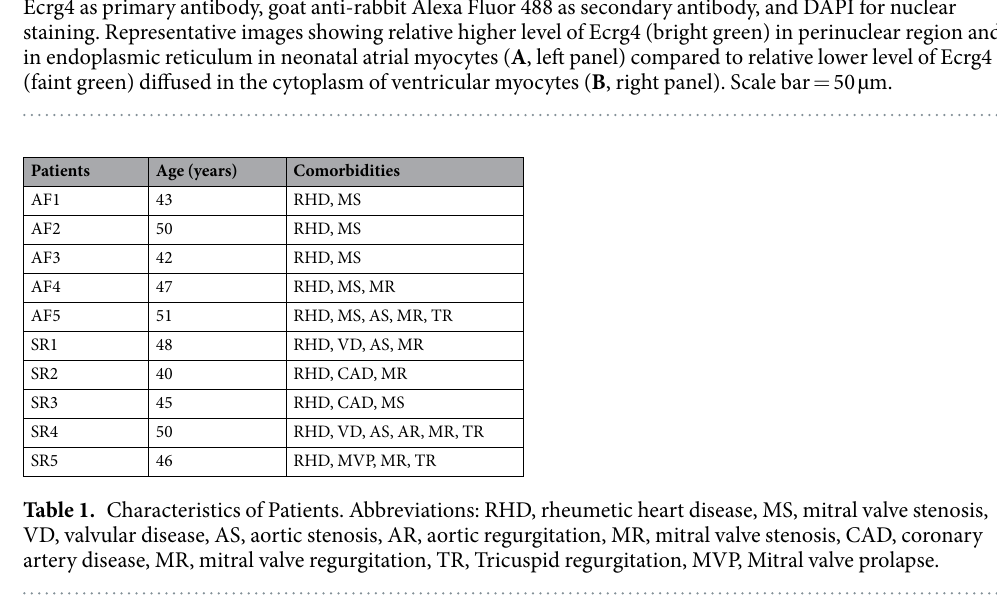
Table 1. Characteristics of Patients. Abbreviations: RHD, rheumetic heart disease, MS, mitral valve stenosis, VD, valvular disease, AS, aortic stenosis, AR, aortic regurgitation, MR, mitral valve stenosis, CAD,